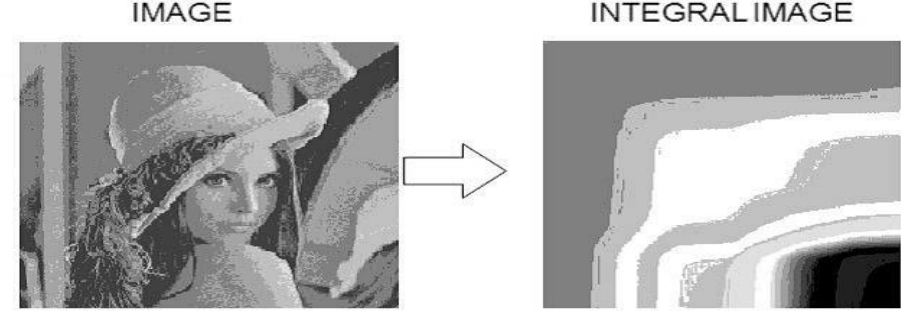
Figure 3. Conversion of the image into an integral image